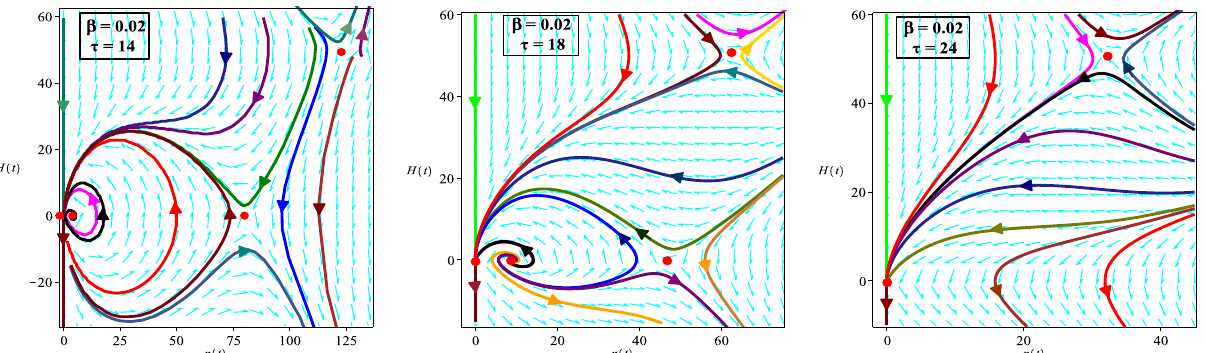
the origin, the other two intersec- tions of T ∗ ( n ∗ ) with T ( n ∗ ), namely the unstable critical point ( n ∗ = 3 . 22 , H ∗ = 0) — non-discernible due to the scale of this diagram ral out and the saddle at ( n ∗ = 80 . 36 , H ∗ = 0), and also the sin- gle intersection point of T ∗∗ ( n ∗∗ ) with T ( n ∗ ), namely the saddle at ( n ∗∗ = 125 . 40 , H ∗∗ = 50).The sad- dle at ( n ∗ = 80 . 36 , H ∗ = 0) is with ρ ∗ < 0. √ Fig. 4 The case of α = 2 with β = 0 . 02. As β < 8 B / m 0 = 0 . 0894, critical points are unstable nodes. Finally, when n ∗ > ( the eigenvalues λ ∗ 22 . 47, the eigenvalues are both real – one positive and one negative are both complex with positive real parts for 1 , 2 = 19 . 70. The trajectories near them are unwind- and one has saddles. As β = 0 . 02 < β Q = 0 . 0343, both eigenvalues 0 < n ∗ < N ∗ 0 λ ∗∗ = 19 . 70 and ing spirals (see a and b ). For values of n ∗ between N ∗ are real and with opposite signs for all n ∗∗ , thus the corresponding √ 0 1 , 2 ( critical points are always 3 / 2 − 1 )/ A = 22 . 47, the eigenvalues are both real and positive. The